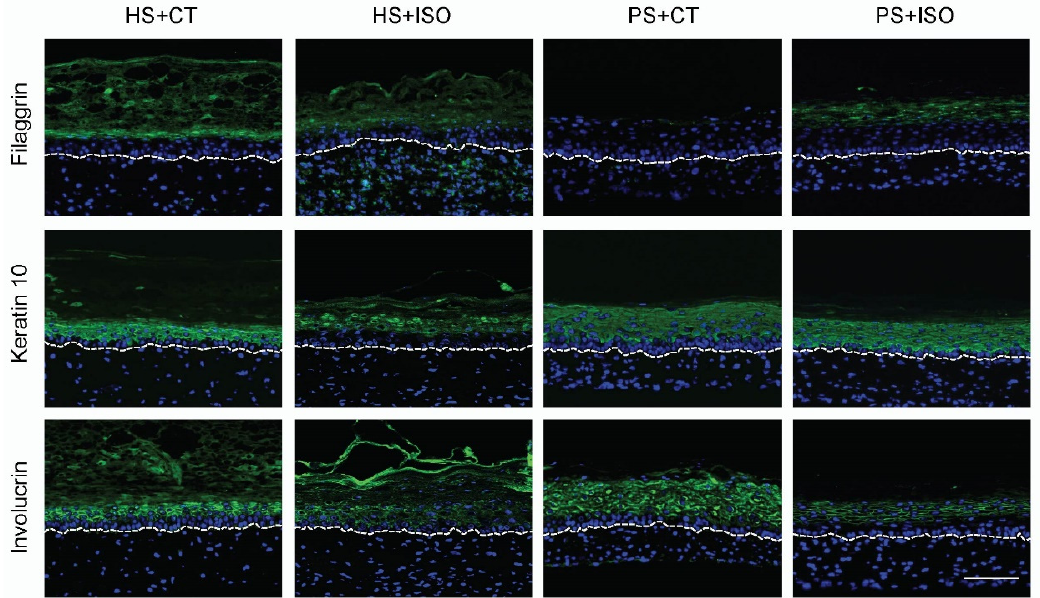
Figure 3. Expression of epidermal differentiation markers (green) in healthy substitutes (HS) and psoriatic substitutes (PS) produced with cholera toxin (+CT) or isoproterenol (+ISO) ( N = 2 donors per condition, n = 3 skin substitutes per donor). The nuclei were stained with Hoechst (blue). The dotted line indicates the dermo-epidermal junction. Scale bar: 100 μ m.